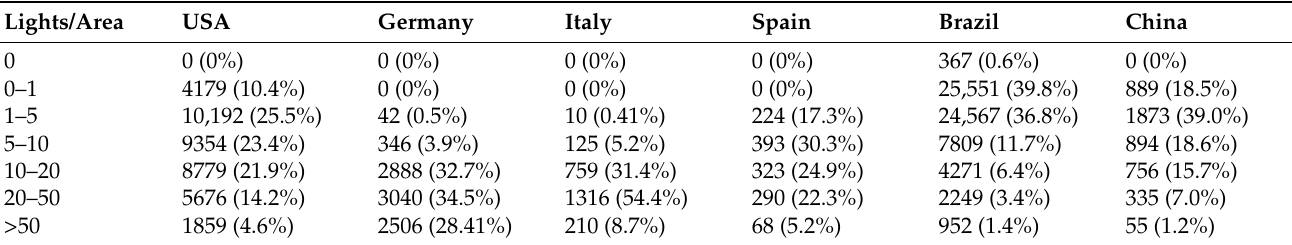
Table 2. Distribution of nightlight density values across subnational